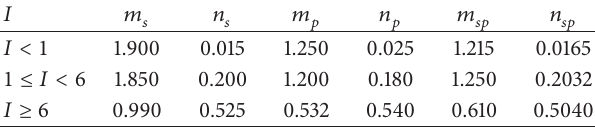
Table 4: The parameters in (47a), (47b), and (47c) for different 𝐼